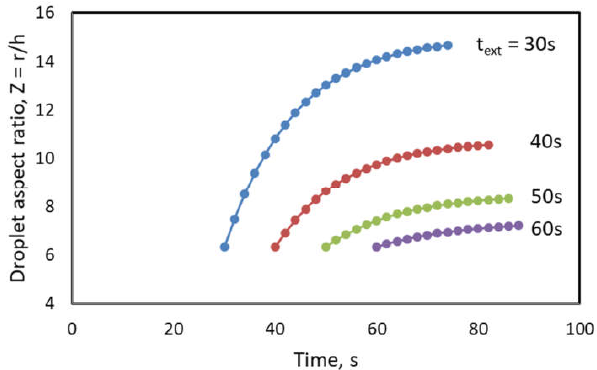
Figure 6. Droplet shape as a function of total time, s, for different extrusion times. ( V = 2 cm 3 , γ = 45 mN/m).